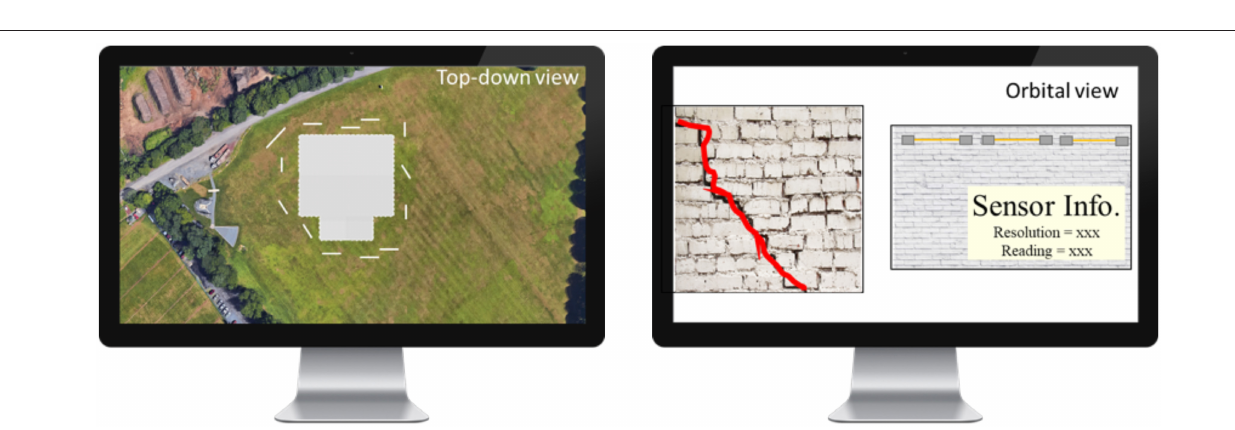
FIGURE 4 | Conceptual design for off site viewing capabilities. Each panel indicates a different viewing mode that the user could choose: (1) the top-down view will situate the captured images on a satellite map to provide contextualization (2) an orbital view will enable a user to interact with individual annotations and “virtually” walk around them and